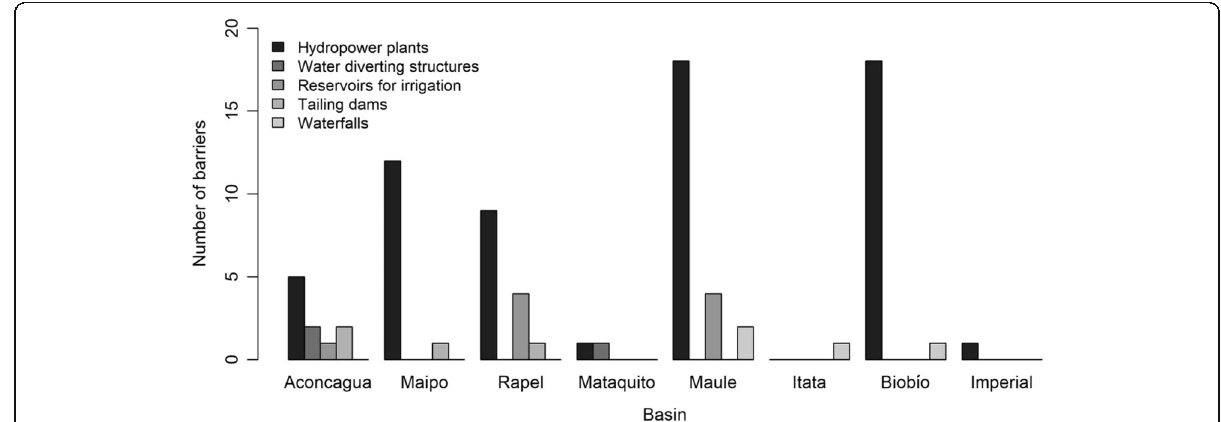
Fig. 5 Distribution of different types of barriers across basins in the current fragmentation scenario